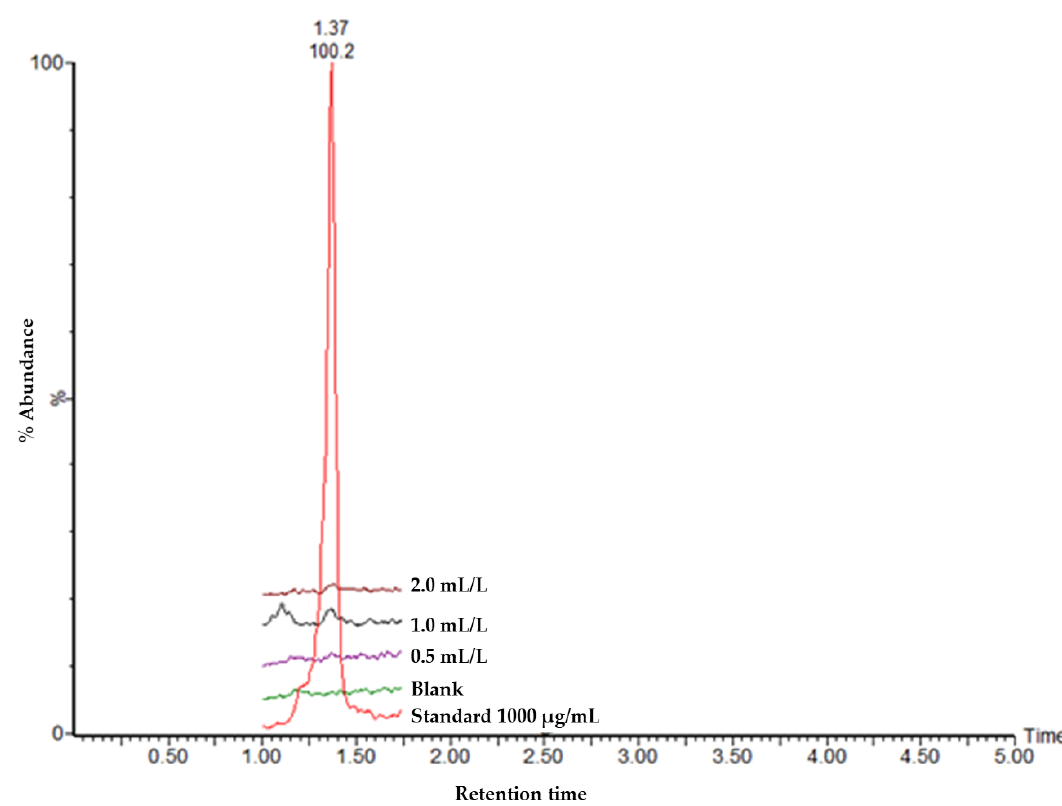
Figure 3. Chromatograms of leaf samples 24 h after two applications of HYM.